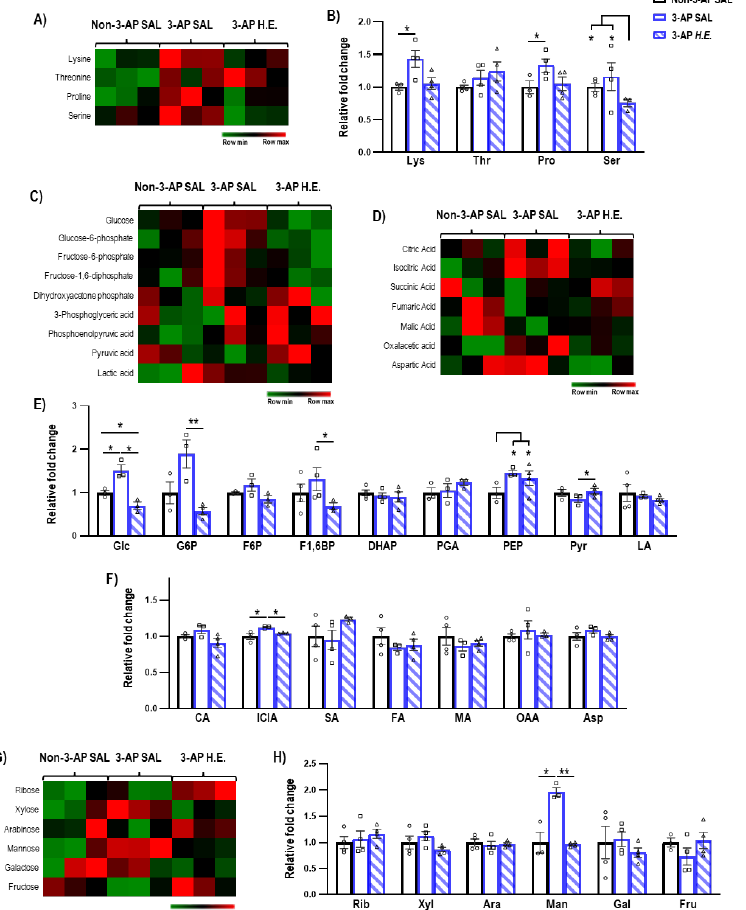
Figure 4. Mass spectrometry analysis of the metabolites changes in the cerebellum. ( A , B ) Heatmap and comparison of the expression of amino acids. ( C , E ) Heatmap and comparison of the expression of glycolysis-related metabolites, ( D , F ) TCA cycle-related metabolites, and ( G , H ) sugars. Indicators: * p -values ≤ 0.05, ** p - values ≤ 0.01 , Non-3-AP SAL group, 3-AP SAL group, 3-AP H.E. group.